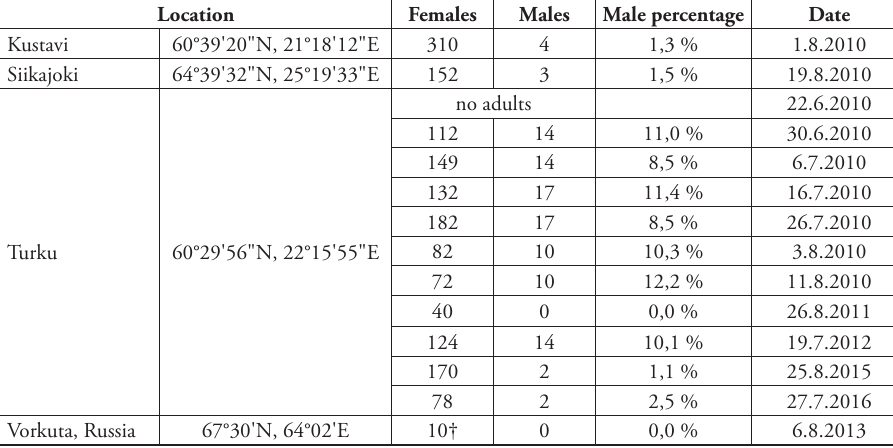
Table 1. Locations, number of females and males, male percentages and collection dates of C. ledi